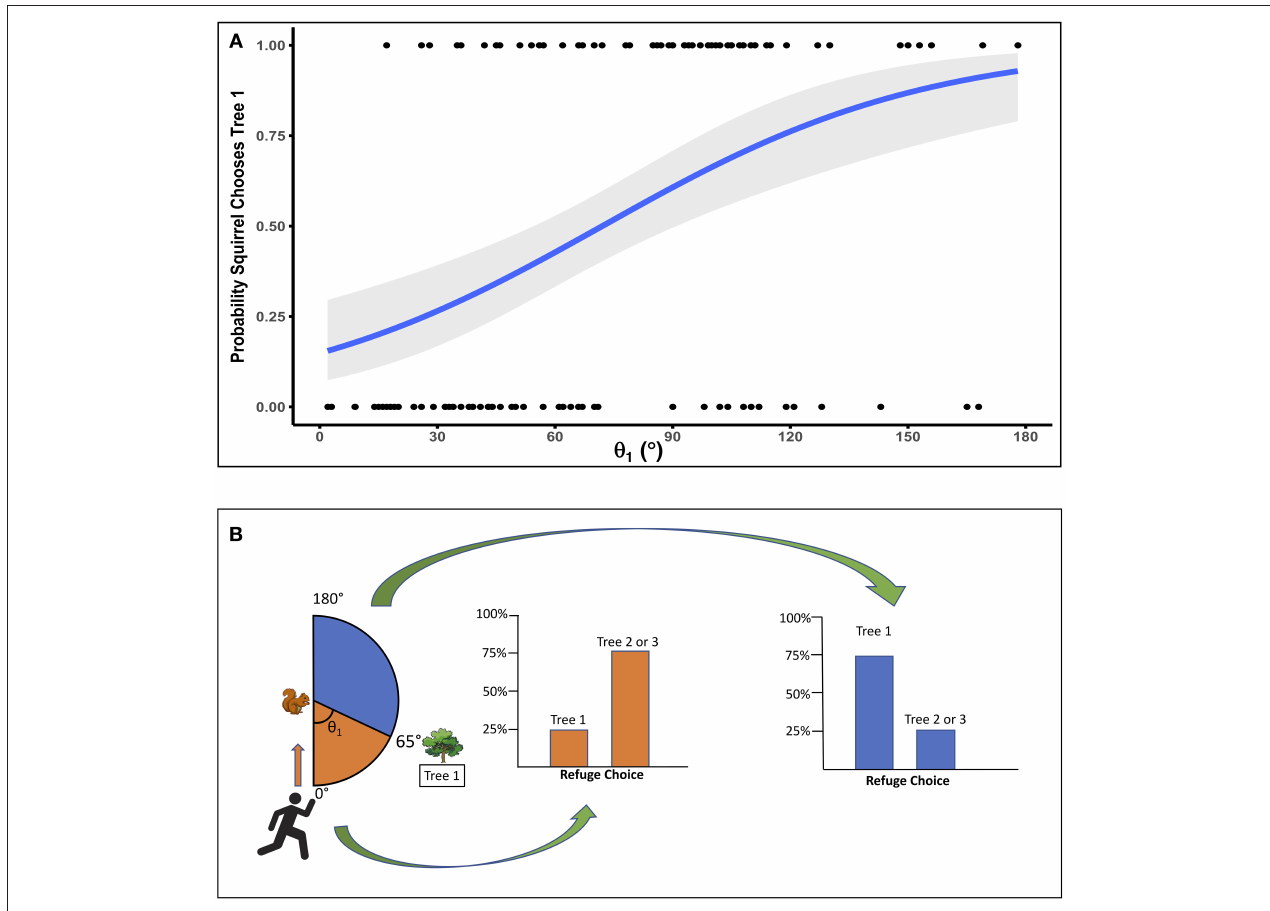
FIGURE 2 | (A) The probability that a squirrel will choose Tree 1 increases as the escape angle to Tree 1 ( θ 1 ) increases, so that the squirrel runs more directly away from the approaching threat to reach that refuge. The probability of a squirrel choosing Tree 1 is 0.5 when θ 1 is 65 ◦ . Gray area indicates SE, and dots show squirrel refuge choices, with a value of 1 for a squirrel that chose Tree 1 and a value of 0 for a squirrel that chose Tree 2 or Tree 3. (B) Squirrels were less likely to select the nearest tree (Tree 1) as a refuge when θ 1 was relatively acute, meaning they had to run in the general direction of the approaching person to reach that tree. When Tree 1 angle ( θ 1 ) was ≤ 65 ◦ , 25% of squirrels chose Tree 1 and 75% chose Tree 2 or 3. When θ 1 was > 65 ◦ , 73% of squirrels chose Tree 1 and 27% chose Tree 2 or